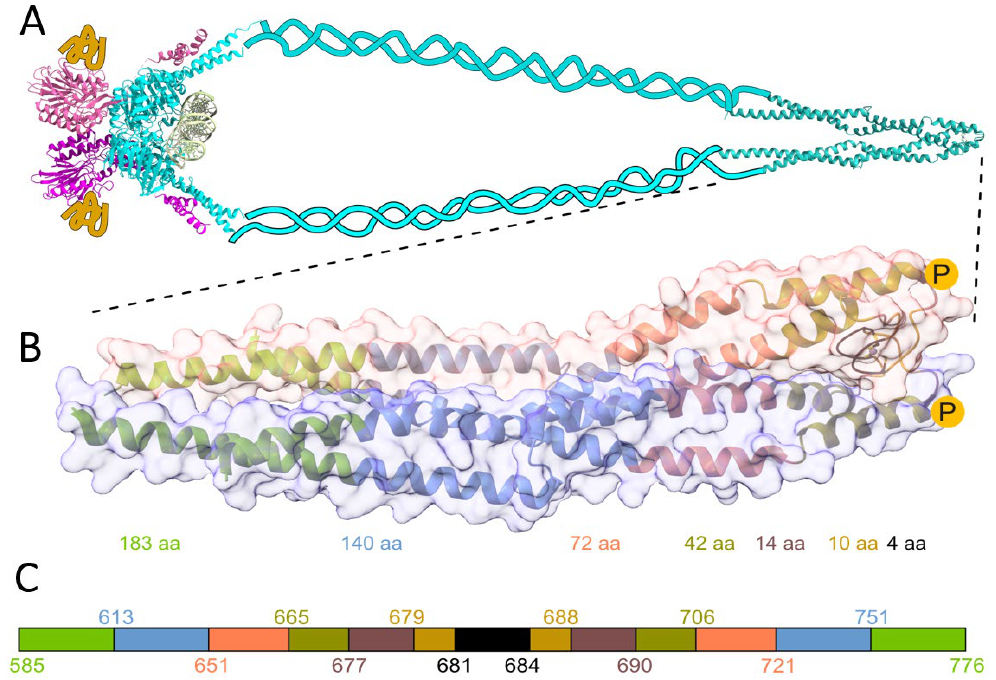
Figure 1. ( A ) Schematic architecture of the MRN complex. Light blue represents Rad50 dimer, pink and yellow structures, and ribbons represent two Mre11 and Nbs1 proteins, respectively. The structural representation of the globular domain of the MRN complex is based on the Methanocaldococcus jannaschii MR core complex bound to DNA (colored light green), (PDB: 5DNY) [20]. Rad50’s zinc hook from H. sapiens is shown magnified below. ( B ) Crystal structure of the investigated Rad50 protein fragment from H. sapiens (PDB: 5GOX) [19] . Zinc hook peptides and proteins ( Hs Hk4 - Hs Hk183) are used in the study to probe the effect of the interface on the Zn( Hs Hk) 2 - complex formation. The yellow circles with P in the middle show the site of phosphorylation of the Thr690 residue. ( C ) Schematic representation of peptides investigated here. The color-coded stretches and numbers represent the start and end of the